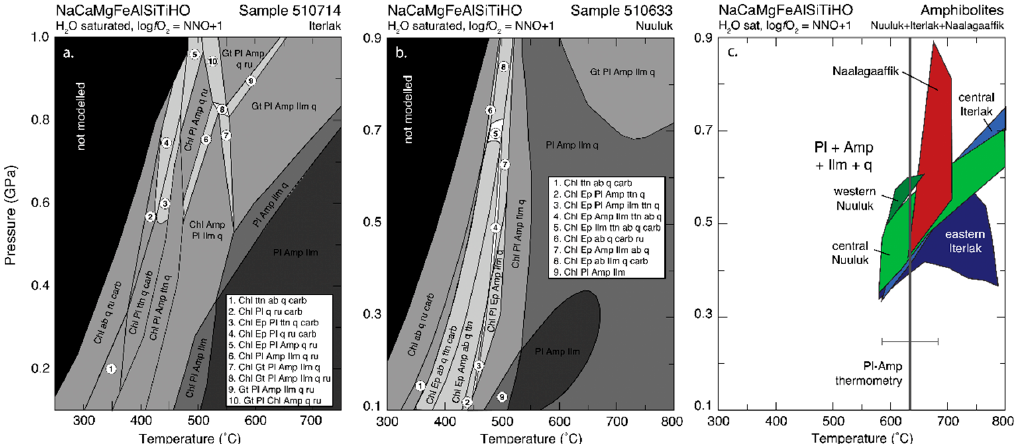
Figure 5. Pseudosection results for Tartoq amphibolite-facies assemblages; ( a , b ) Typical pseudosections for Iterlak and Nuuluk amphibolites with a pl-amp-ilm-q peak paragenesis; ( c ) Compilation of all pseudosection fields for the pl-amp-ilm-q amphibolite-facies parageneses in Nuuluk, Naalagaaffik and Iterlak, where the boxes represent the P–T constraints from the overlap in these fields. Plagioclase-amphibole thermometry is in good agreement with pseudosection constraints. Minerals starting with a capital letter were modelled as a solid solution. Mineral abbreviations as in Figure 3 and carb = carbonate.